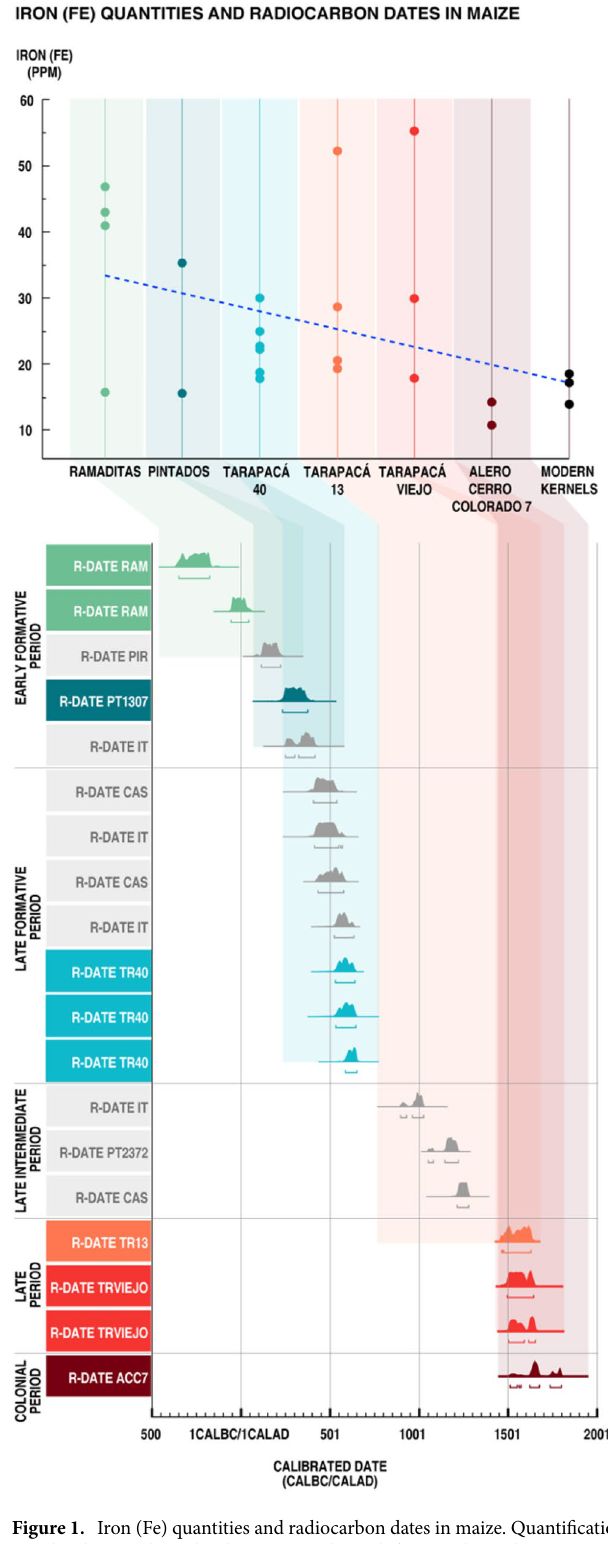
Figure 1. Iron (Fe) quantities and radiocarbon dates in maize. Quantifications of iron concentration in kernels are shown in color dots. Each site has been assigned to a different color and a time period. Linear regression is expressed in the dotted line. Linear regression results are: F-statistic = 4.57(1.23), R 2 = 0.166, R 2 adjusted = 0.129, p-value = 0.0432. The regression was calculated based on the quantities of iron in kernels and we assigned an archaeological date to each archeological site indicated in the X bar. Date was assigned as years before present. Thus, we used quantitative dates. Radiocarbon dates are indicated in color bars which are the sum of probabilities for 19 dates. Dates in color are the maize kernels for the same archaeological site used in Fe analysis. Dates in grey are reported for maize kernels from other sites for Tarapacá region. Dates range from ca. 400 BC to ca. 1799